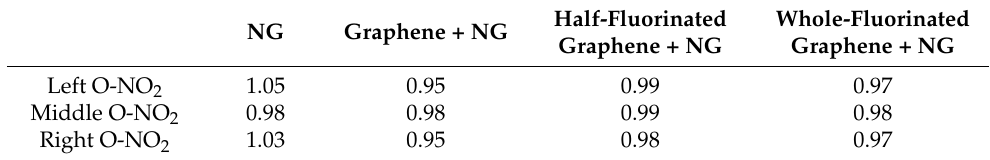
Table 3. ELF-OS value of O-NO 2 in different NG.